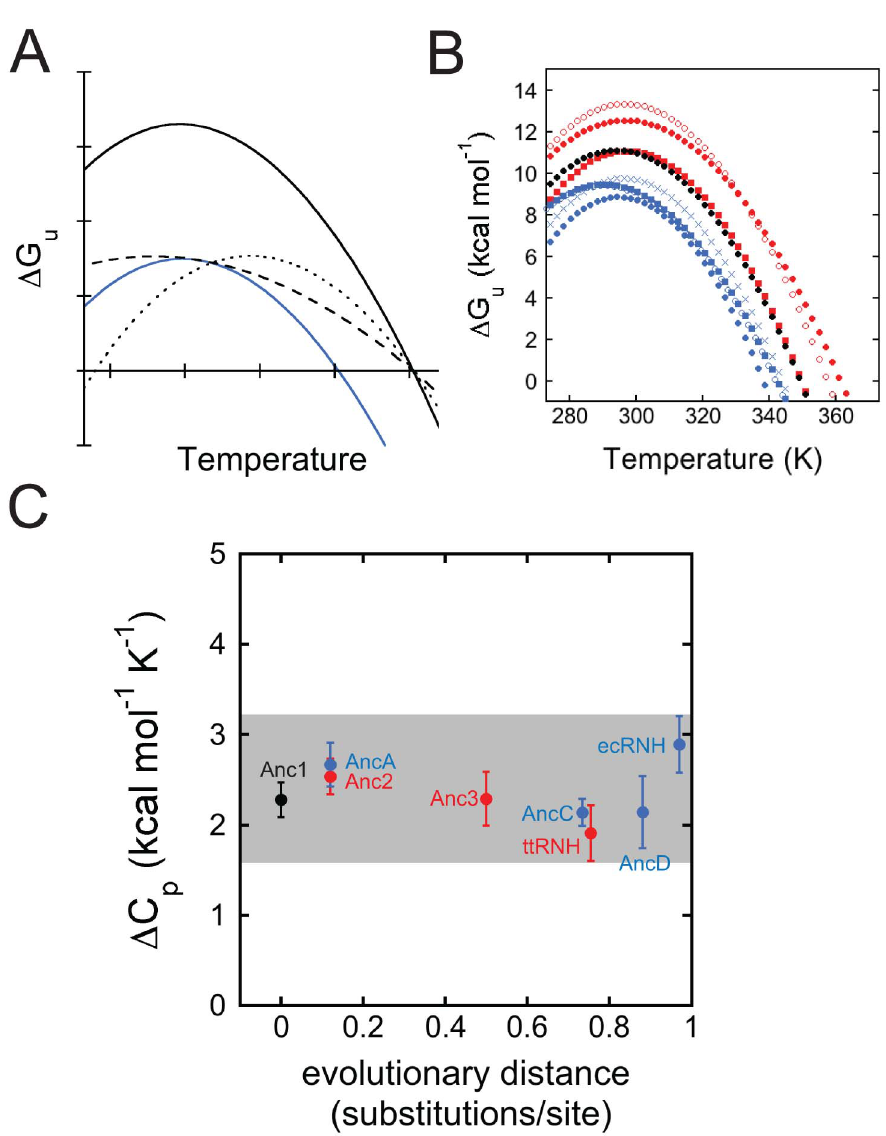
Figure 4. All possible mechanisms for manipulating T m are represented in RNH’s evolutionary history. (A) Thermodynamic strategies for increasing T m . Relative to the reference state (blue line), the stability curve can be upshifted (solid black line), broadened (dashed line), or right-shifted (dotted line). (B) Superimposed stability curve fits for ecRNH (blue solid circles), ttRNH (red solid circles), Anc1 (black solid circles), ancestors from the mesophilic lineage (AncA, blue Xs; AncC, blue solid squares; AncD blue open circles), and ancestors from the thermophilic lineage (Anc2, red solid squares; Anc3, red open circles). (C) D C p as function of evolutionary distance from Anc1. See also Dataset